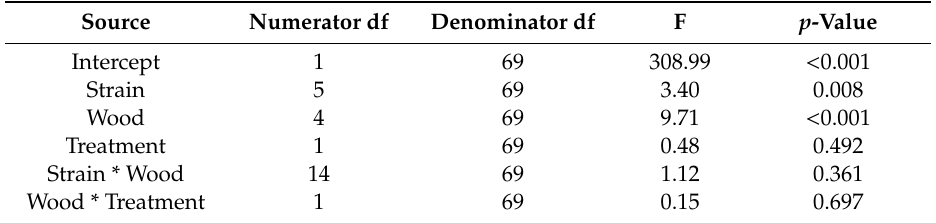
Table 2. Effect of the factors strain, wood and treatment on the yield of G. lucidum (Equation (2), Type III test).